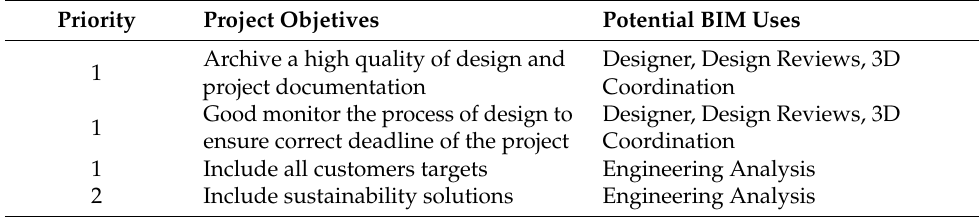
Table 7. Projects objectives and potential BIM Uses.